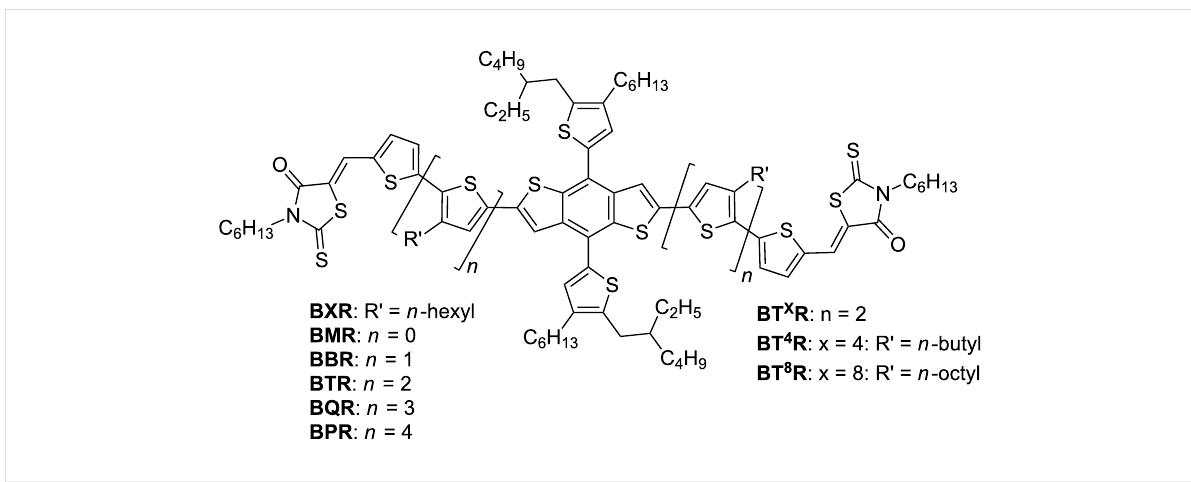
Figure 1: Chemical structures of molecular materials with the following variations; BT x R , alkyl side chains of the terthiophene bridging arm and BXR , oligothiophene bridging arm.